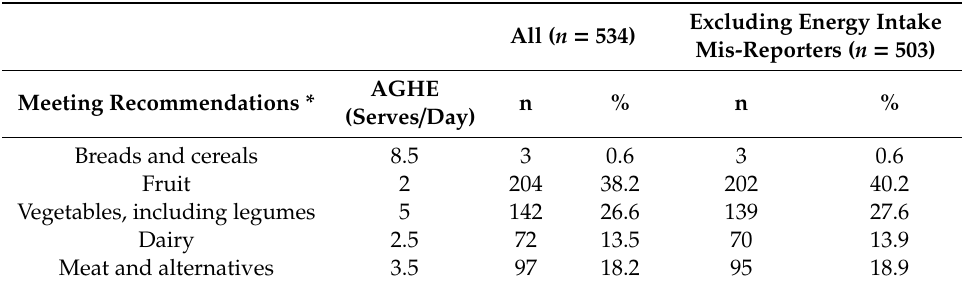
Table 3. Percentage of pregnant women achieving Australian Guide to Healthy Eating (AGHE) daily food group recommendations.